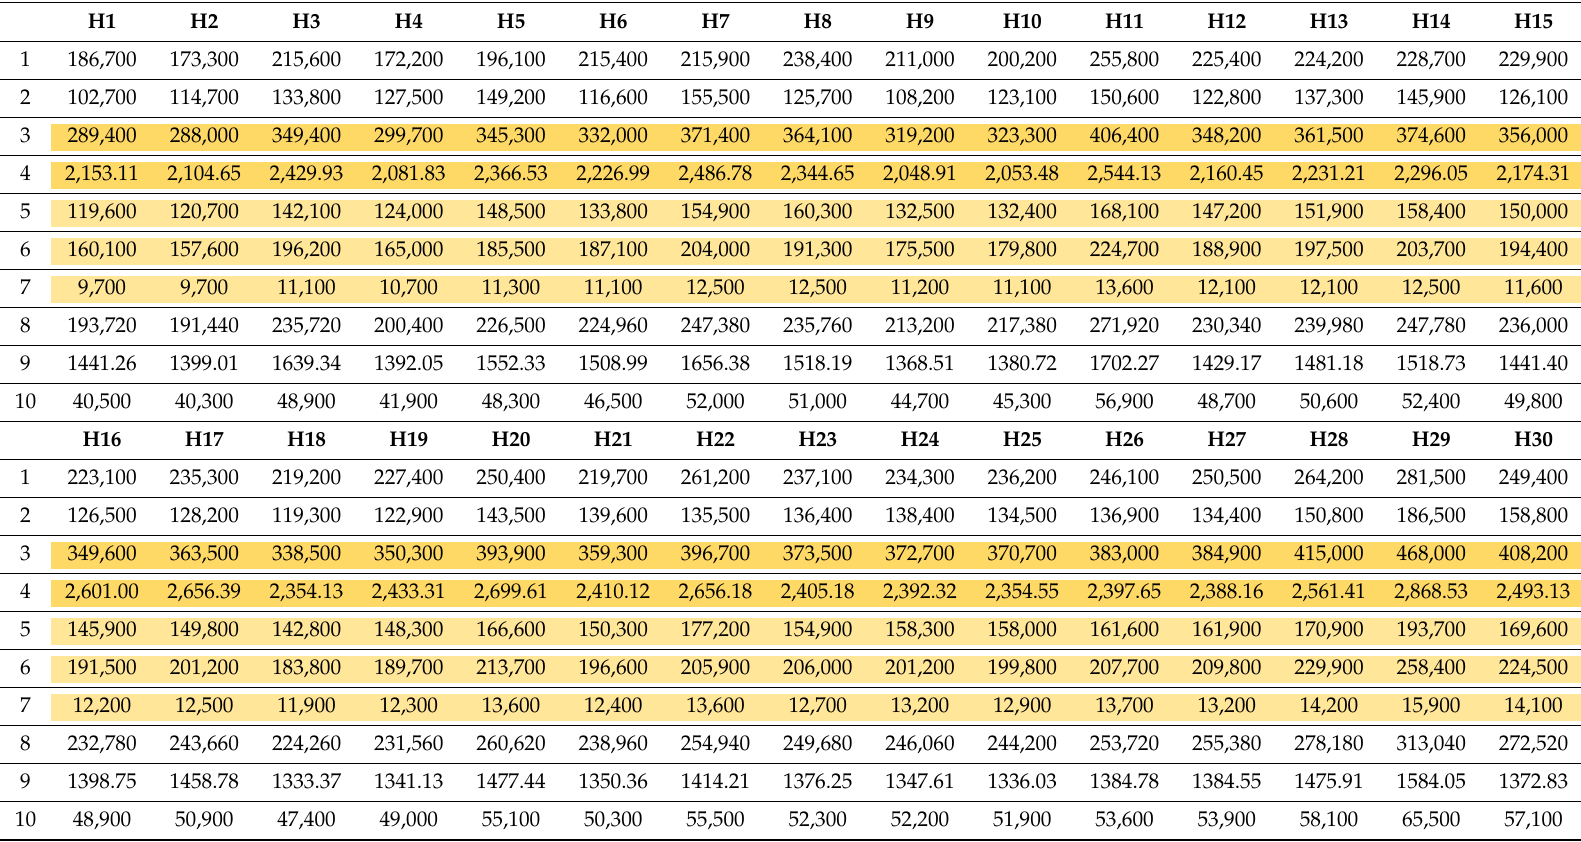
Table A1. Selected parameters of the buildings of the H1–H30 building set (Part I): (1) Unfinished state closed (minimal cost) (PLN); (2) Finishing works in building construction (minimal cost) (PLN); (3) Total minimal cost of construction works; (PLN); (4) Total minimal cost of construction works per 1 m 2 (PLN); (5) Breakdown of the costs of works (national minimum rates) (PLN) Labor: working hour “R”, (6) Materials “M”, (7) Equipment “S”; (8) Total minimal cost of construction